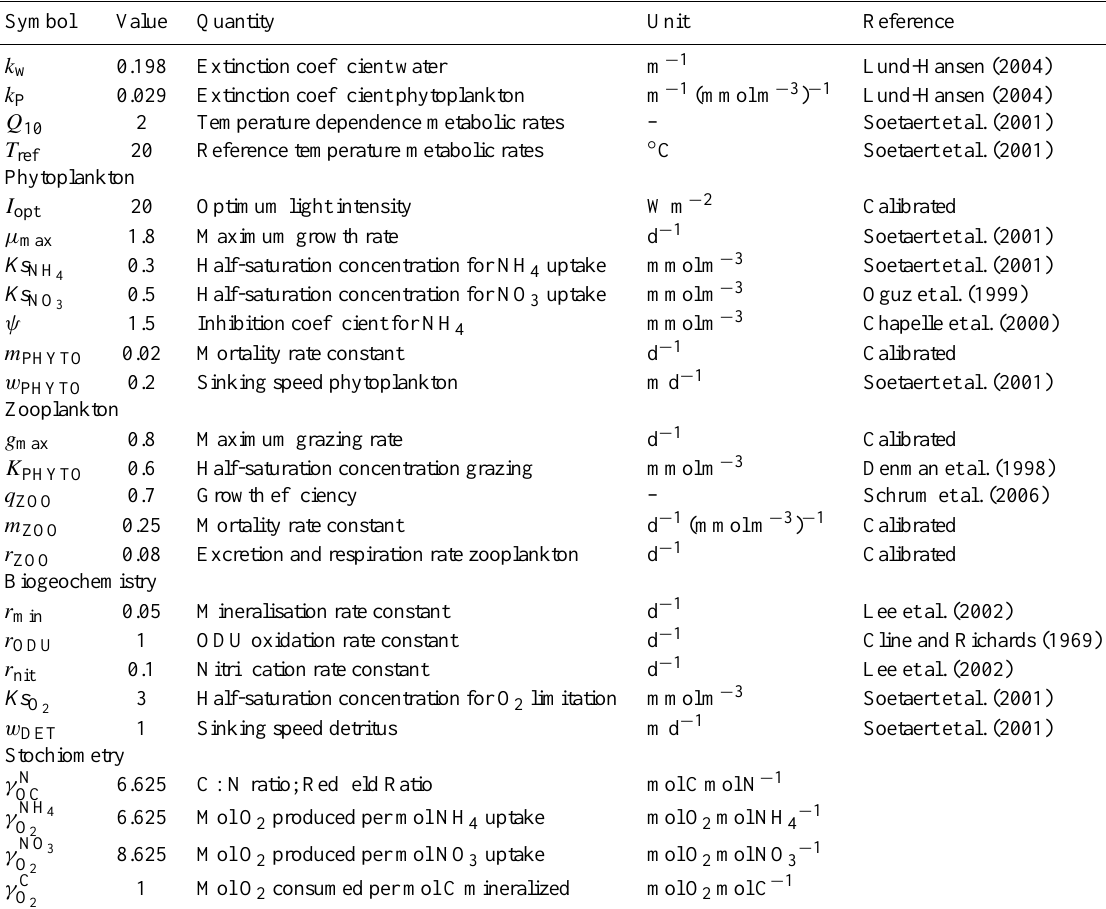
Table 8. Parameter values of the pelagic ecosystem model. All rate parameters are defined at 20 ◦ C. Symbol